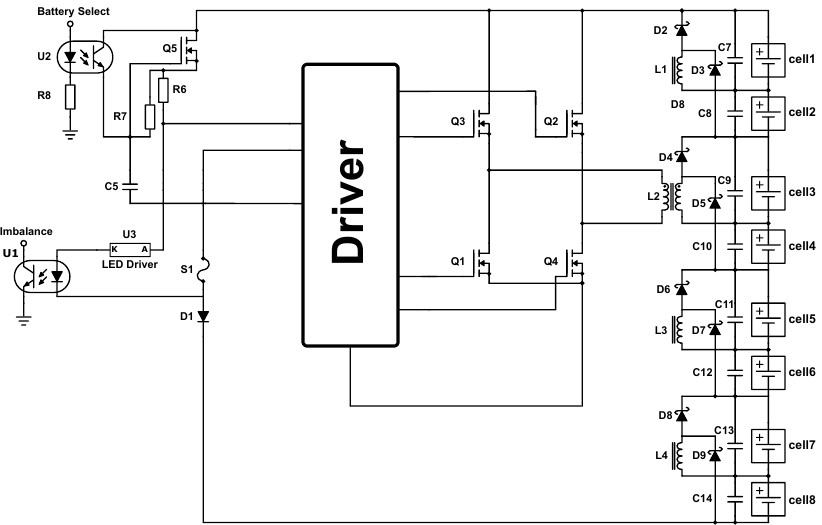
Figure 3. The simplified schematic of the proposed balancing